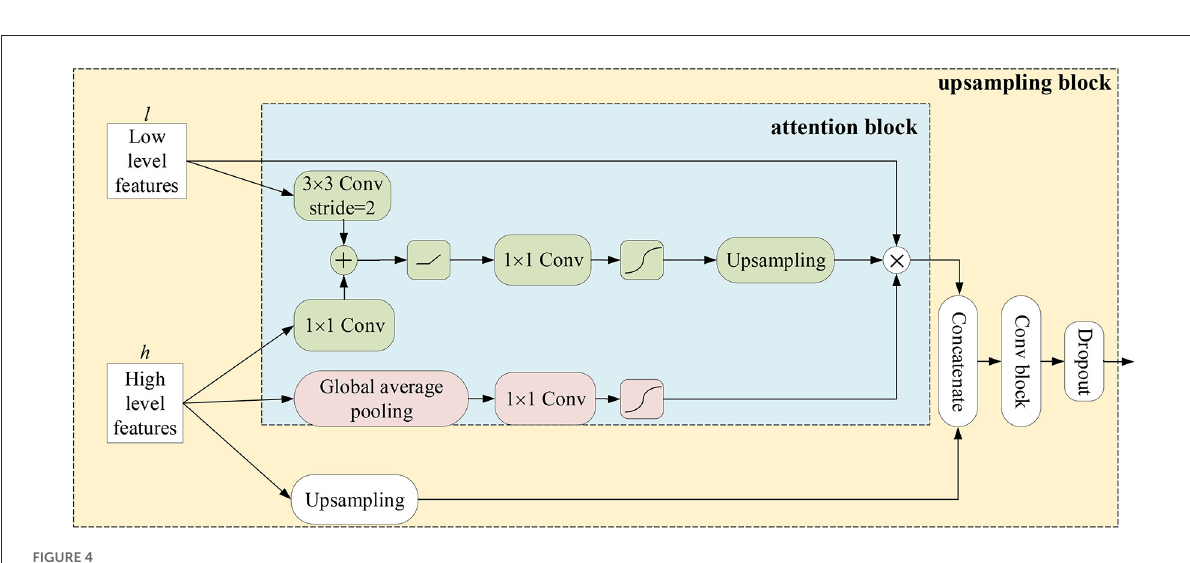
FIGURE4 An illustration of attention blocks and upsampling